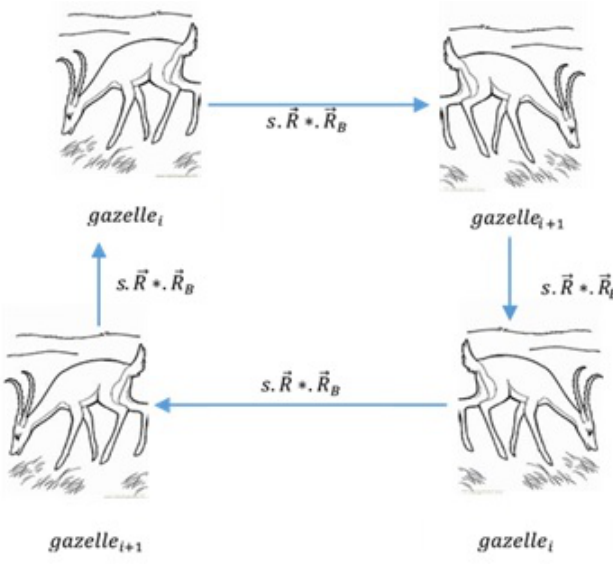
Figure 1. The gazelle’s grazing pattern denotes